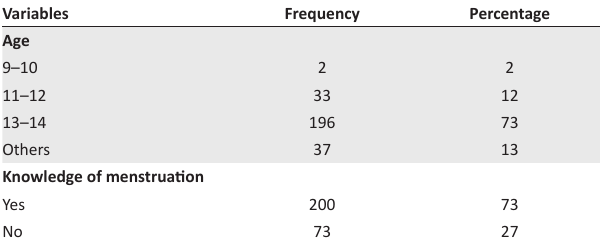
TABLE 1: Respondents’ age at menarche and knowledge of menstruation ( n = 273). Variables